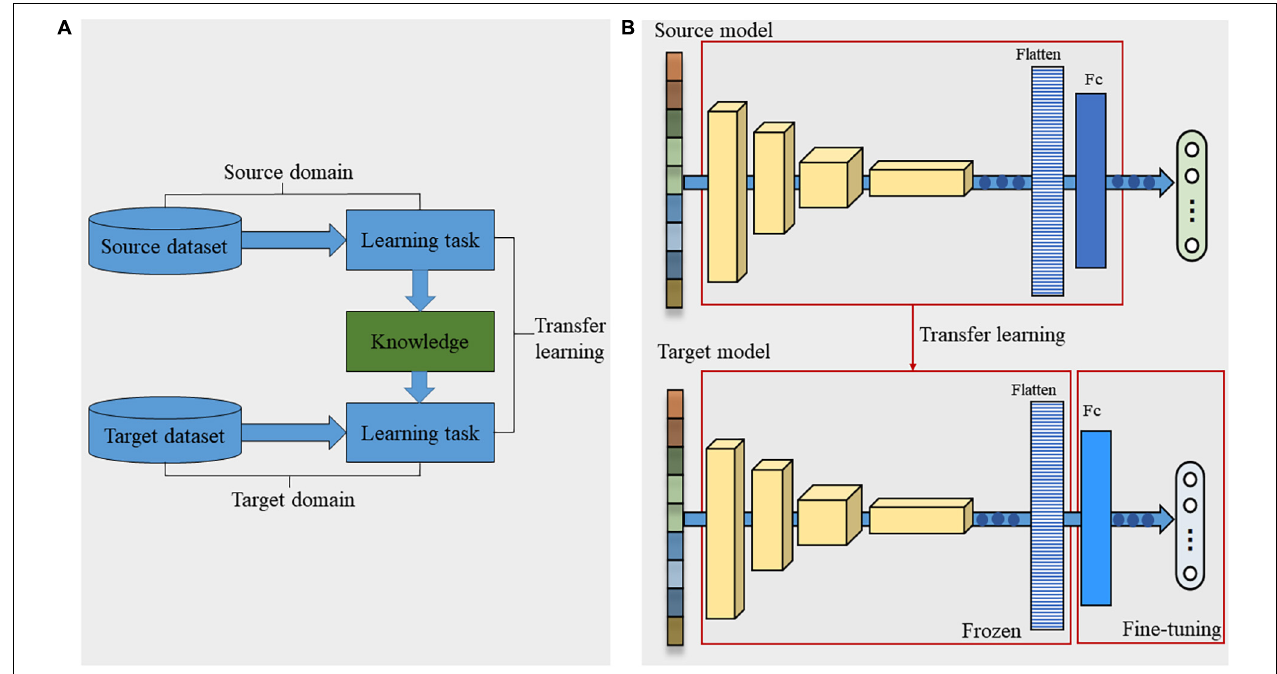
FIGURE 3 | Transfer learning strategy. (A) The typical process of transfer learning. (B) The deep transfer learning strategy in this study. The yellow cubes of different sizes represented multiple cascaded convolution layers. The striped bars and blue bars still represented the flattened layer and the fully connected